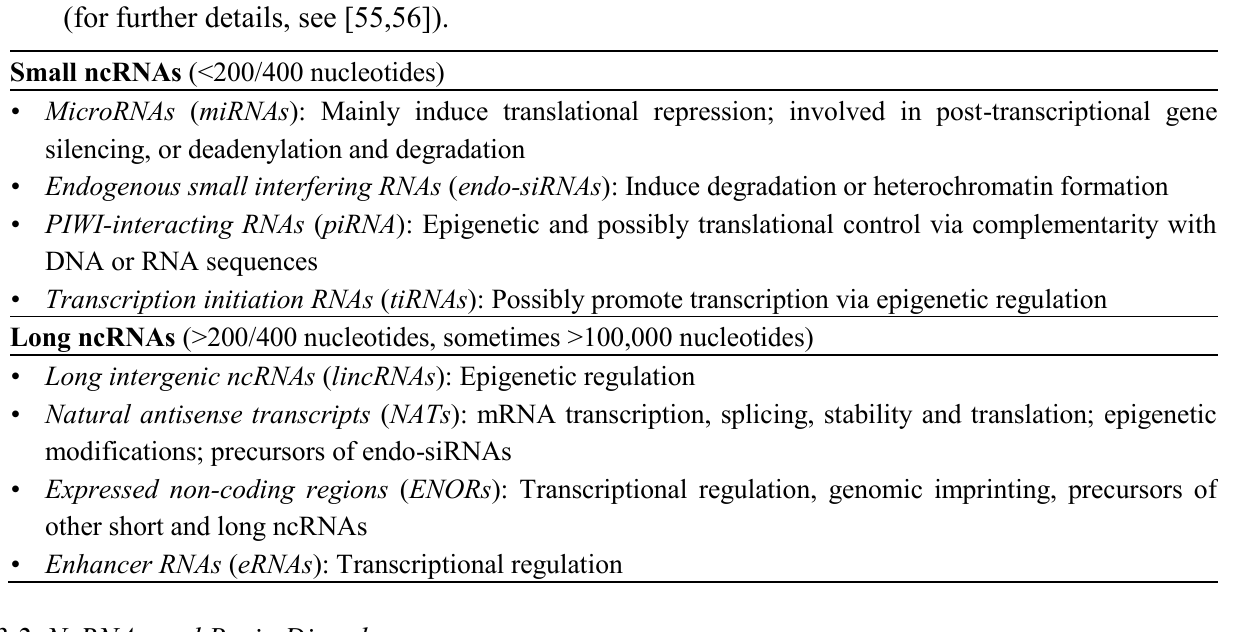
Table 1. Examples of non-coding RNAs (ncRNAs) and their molecular functions (for further details, see